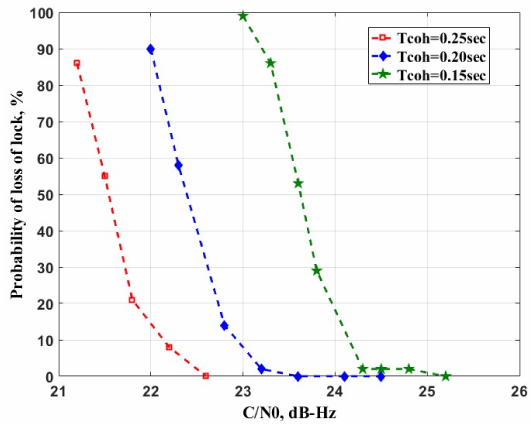
Figure 17. Probability of loss of lock versus carrier-to-noise density ratio